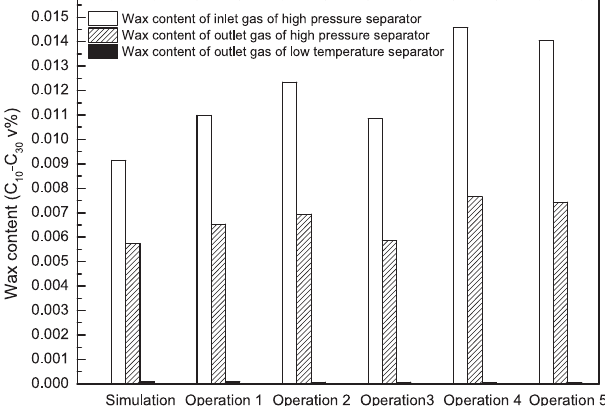
Fig. 14. The gas-liquid equilibrium of sales gas.